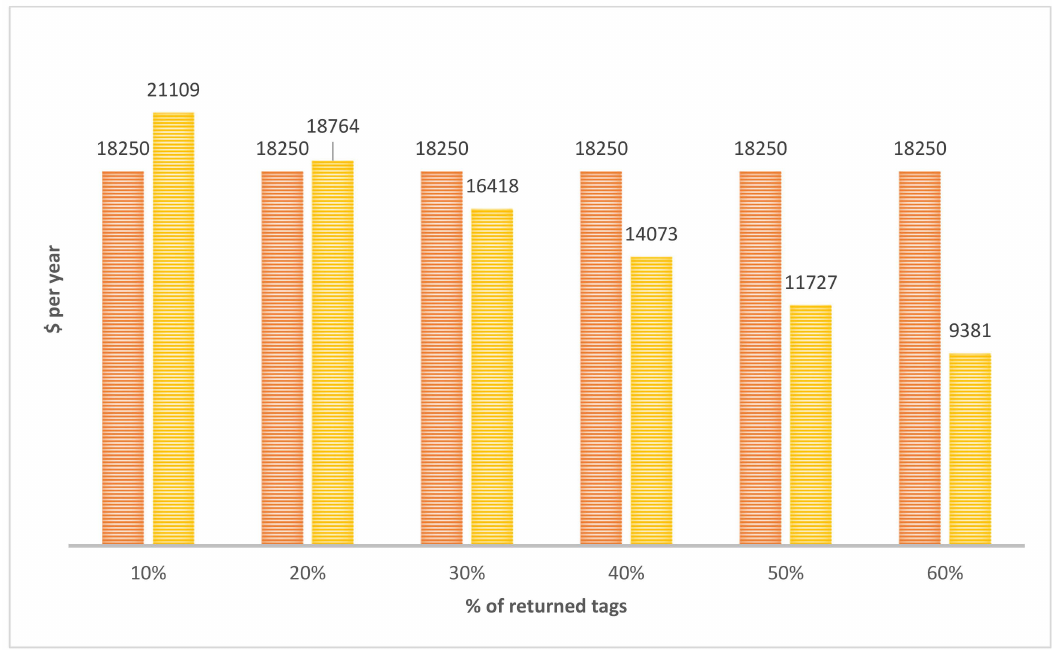
Figure 7. Annual cost projections for standard, non-reusable tags versus reused tag with di ff erent percentages. The blue bars represent the standard tags while the orange bars indicate the reuse tag